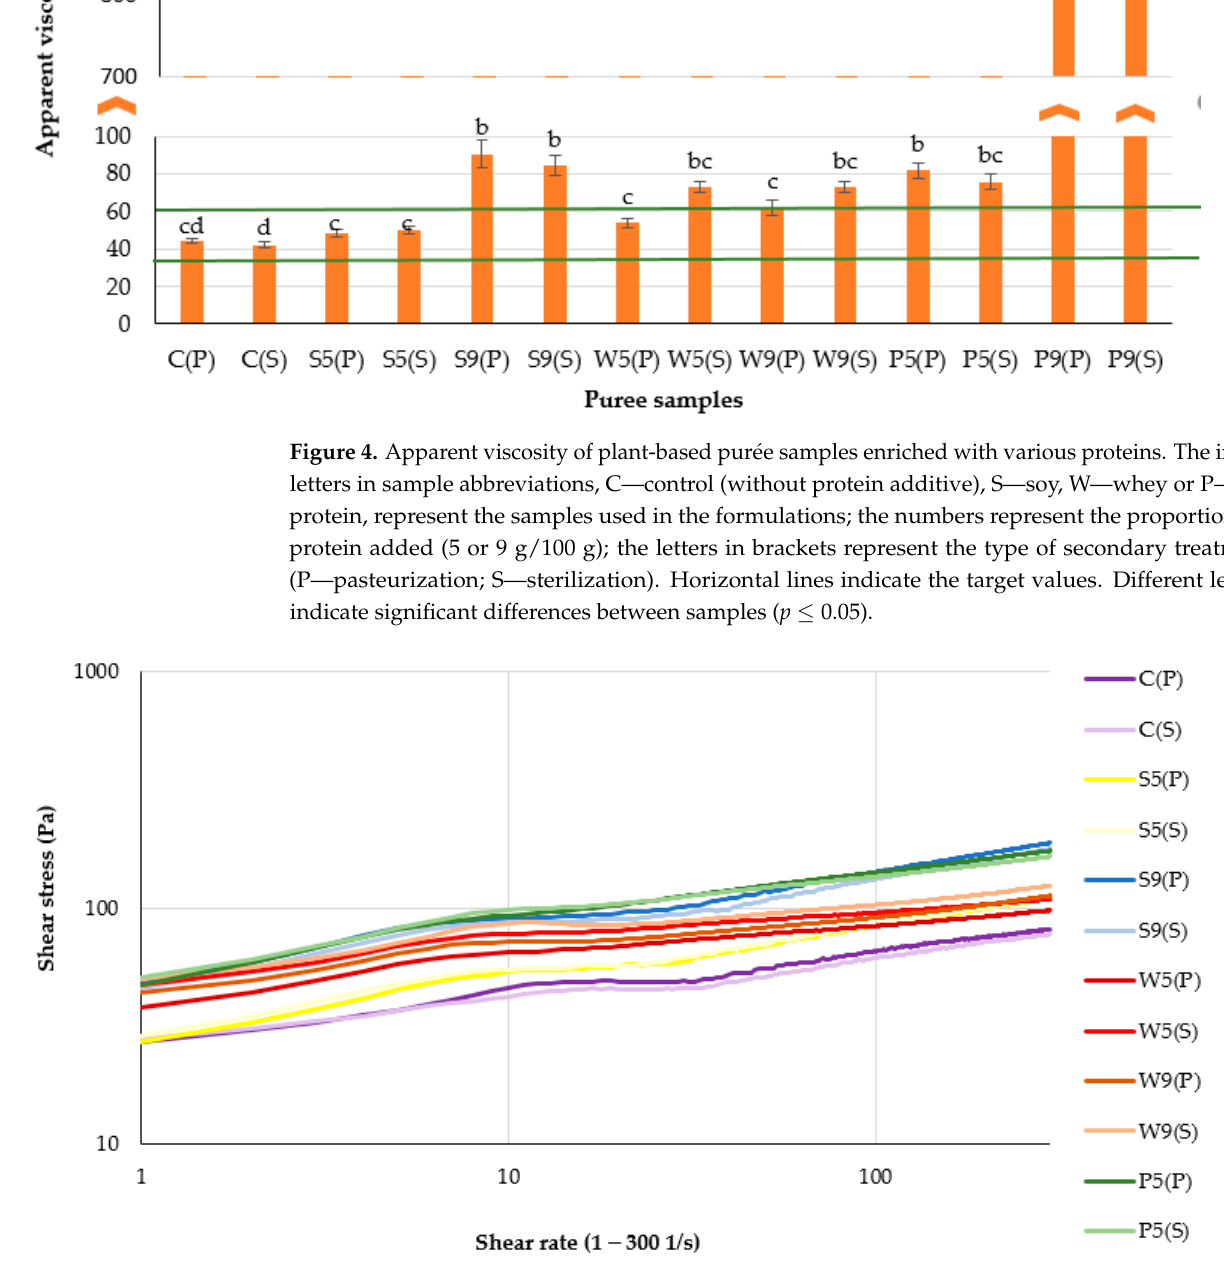
Figure 5. Flow behavior of plant-based pur é es depending on protein type used and treatment applied. The initial letters in sample abbreviations, C—control (without protein additive), S—soy, W—whey or P—pea protein, represent the samples used in the formulations; the numbers represent the proportions of protein added (5 or 9 g/100 g); the letters in bracket represents the type of secondary treatment (P—pasteurization; S—sterilization). Due to the experimental problems related to the high consistency, it was not possible to measure viscosity for the samples P9(P) and P9(S).